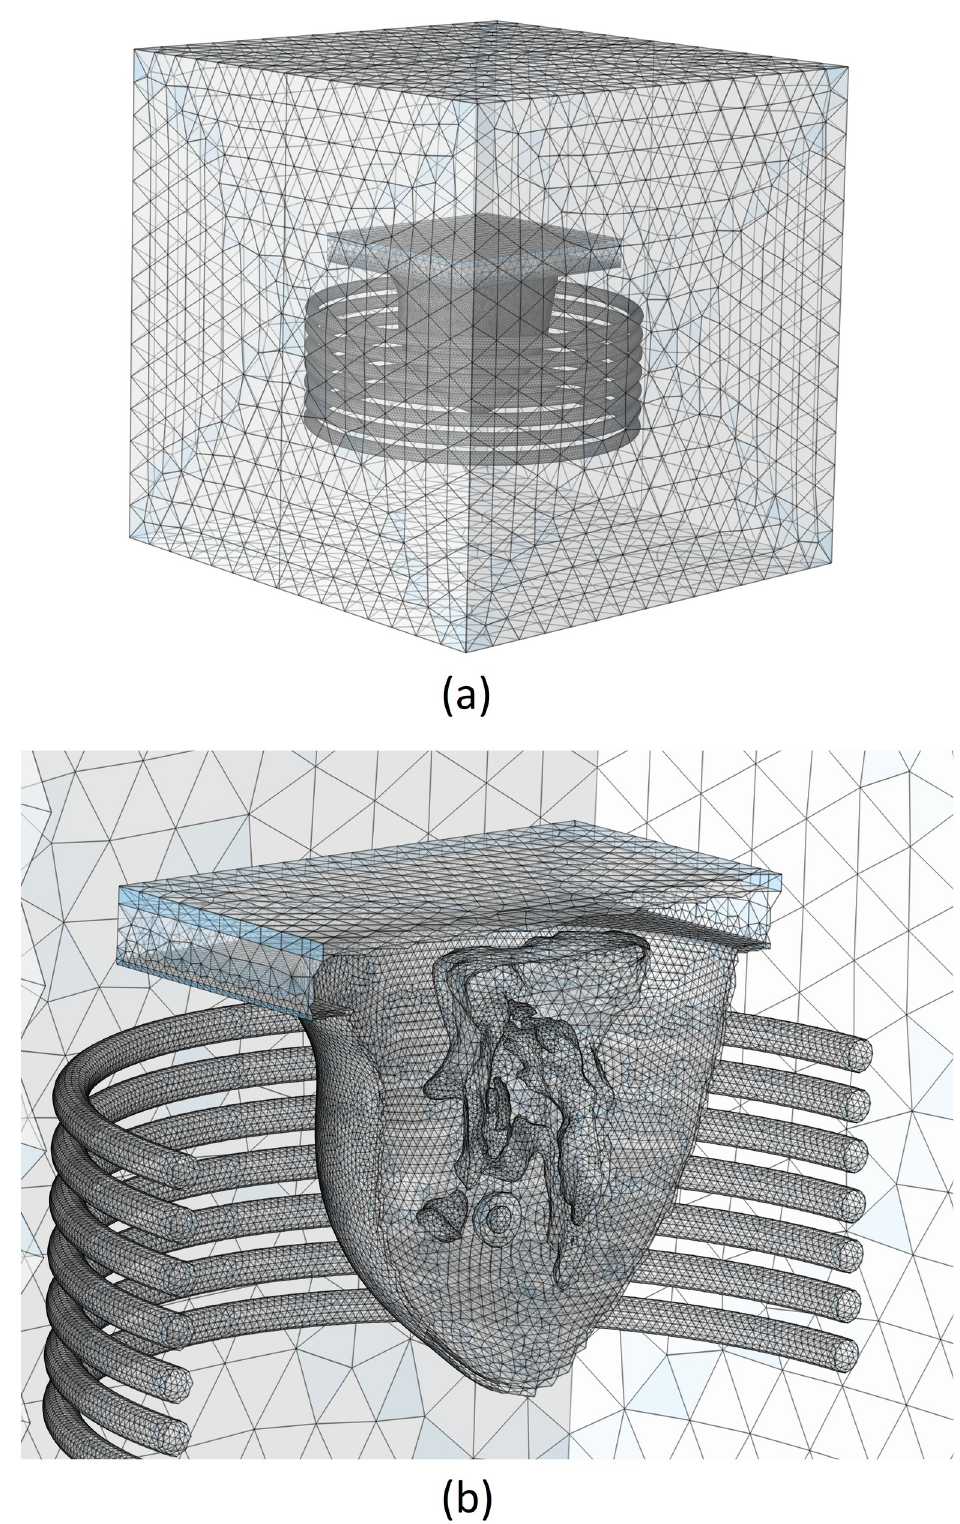
Fig 9. Optimum grid generation considered. (a) whole geometry, (b) sliced magnified model.